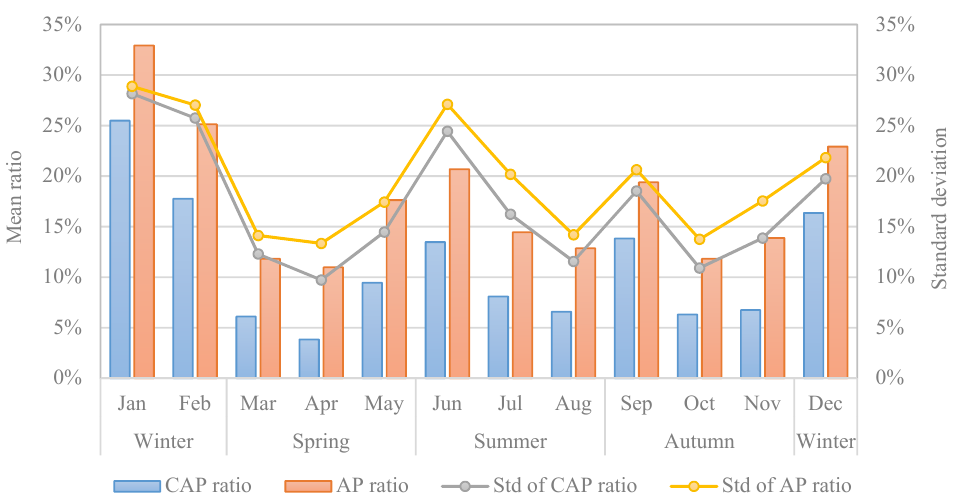
Figure 3. Temporal pattern of continuous air pollution in China.